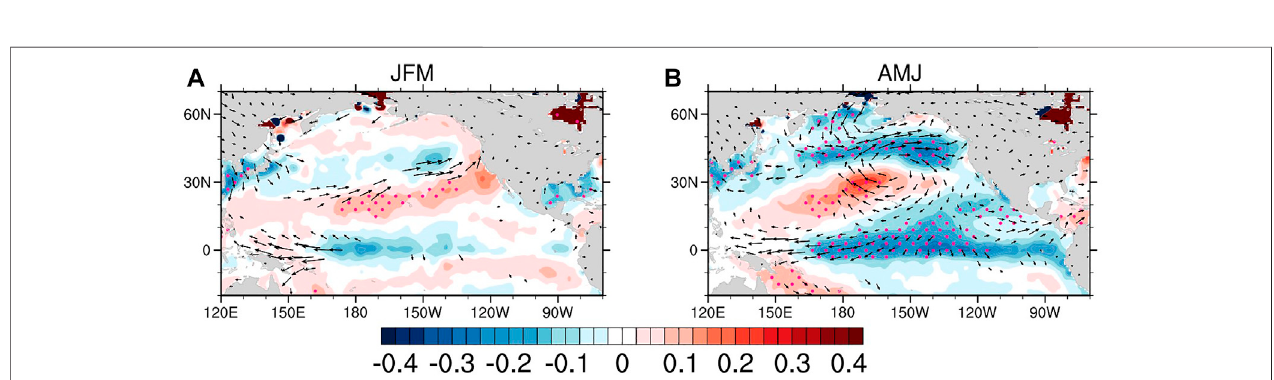
FIGURE 7 | Regression of SST anomalies ( ° C) and 10-m winds (vectors; m s − 1 ) anomalies in (A) JFM and (B) AMJ onto the normalized JFM SHI index. Stippled regions indicate anomalies signi fi cant at the 90% con fi dence level. Only wind anomalies signi fi cant at the 90% con fi dence level are plotted.